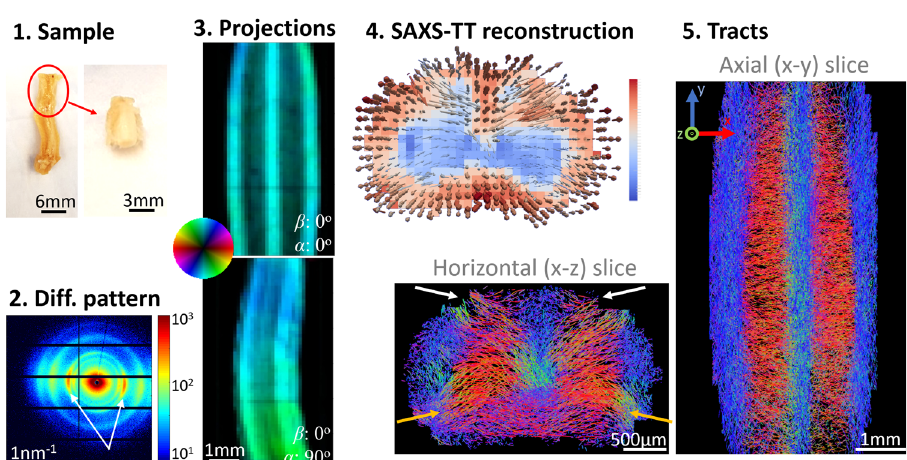
Fig. 2 SAXS-TT results for mouse brain. a Sagittal, axial, and coronal virtual slices of tensor-reconstructed reciprocal space-map intensity at myelin peak q -values. Grayscale colormap was used for the unspeci fi c scattering signal, akin to unspeci fi c tomographic contrasts such as MRI or CT. b Same virtual slices depicting the tensor-reconstructed myelin-speci fi c signal. “ Hot ” colormap was used for the myelin-speci fi c signal, akin to molecular imaging outcomes, e.g. using fl uorescent tags. c 3D myelin distribution map of highly myelinated areas (red). d Coronal slice of the 3D fODF map, with tensors represented by ellipsoids, colored by tensor trace. e Side-view of 3D map of fi ber orientations, represented by lines. Color and orientation correspond to the largest tensor eigenvalue. f Same coronal slice as in a , b , d from map in e . g Tractogram of same section based on main fi ber orientation. h Box plots displaying myelin levels for different regions of the mouse brain, for right and left hemisphere, segmented using the DSURQE mouse brain atlas 48 . Notches represent median values, boxplot upper/lower ends represent 25/75 percentiles, and whiskers extend to ±2.7 standard deviations from the mean. Outliers are in red dots. All white matter regions (CIN, AC, CC, CP, CST, IC, CBP, OPT) displayed statistically similar myelin levels between left and right hemispheres using unpaired two-tailed t -test (no multiple comparison correction). [VEN: lateral ventricles, n right / n l eft = 319/334, p value: 4 × 10 − 9 ; CRUS: crus 1&2, cerebellar lobule 7 (gray matter), n right / n left = 7844/8591, p value: 2 × 10 − 6; OBGL: olfactory bulb, granule layer (gray matter), n right / n left = 5846/ 5889, p value: 0.02; CIC: cingulate cortex, n right / n left = 6273/6004, p value: 4 × 10 − 3 ; AMY: amygdala, n right / n left = 11,191/12,069, p value: 0; SSC: secondary somatosensory cortex, n right / n left = 4381/4318, p value:3 × 10 − 9 ; PVC: primary visual cortex, n right / n left = 887/938, p value: 0.06; BF: barrel fi eld, n n = 5695/6516, p value: 2 × 10 − 14 ; HP: hippocampus, n n = 29368/29811, p value: 10 − 25 ; HTH: hypothalamus, n n = 13,423/13,413, right / left right / left right / left p value: 5 × 10 − 14 ; STR: striatum, n n = 28218/28766, p value: 3 × 10 − 13 ; TH: thalamus, n n = 22,630/22,812, p value:10 − 20 ; GLP: globus right / left right / left pallidus, n right / n left = 3456/3723, p value: 0.28; CIN: cingulum, n right / n left = 162/114, p value: 0.58; AC: anterior commissure, n right / n left = 360/426, p value: 0.43; CC: corpus callosum, n right / n left = 15,467/15,441, p value: 0.81; CP: cerebral peduncle, n right / n left = 2115/2178, p value: 0.17; CST: cerebrospinal tract, n n = 2081/1977, p value: 0.54; IC: internal capsule, n n = 3304/3221, p value: 0.84; CBP: cerebellar peduncle, n n = 3513/3748, right / left right / left right / left p value: 0.21; OPT: optic tract, n n = 1862/2056, p value: 0.70]. Source data are provided as a Source Data fi le. right/ left